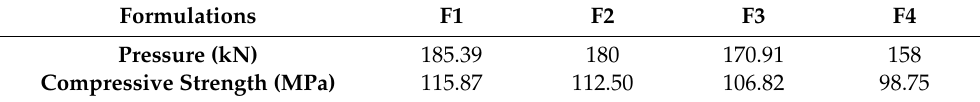
Table 7. Compressive strength of the SN-modified underwater composite-repairing materials.